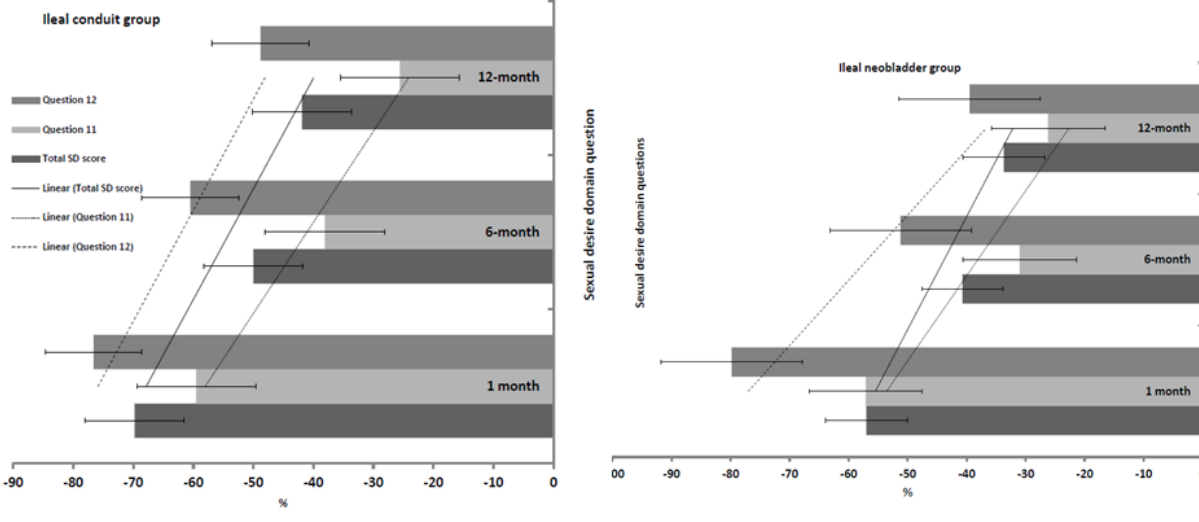
Figure 2 - Percent changes from baseline in sexual desire domain total score and questions during follow-up period. Bars represent error bars with standard